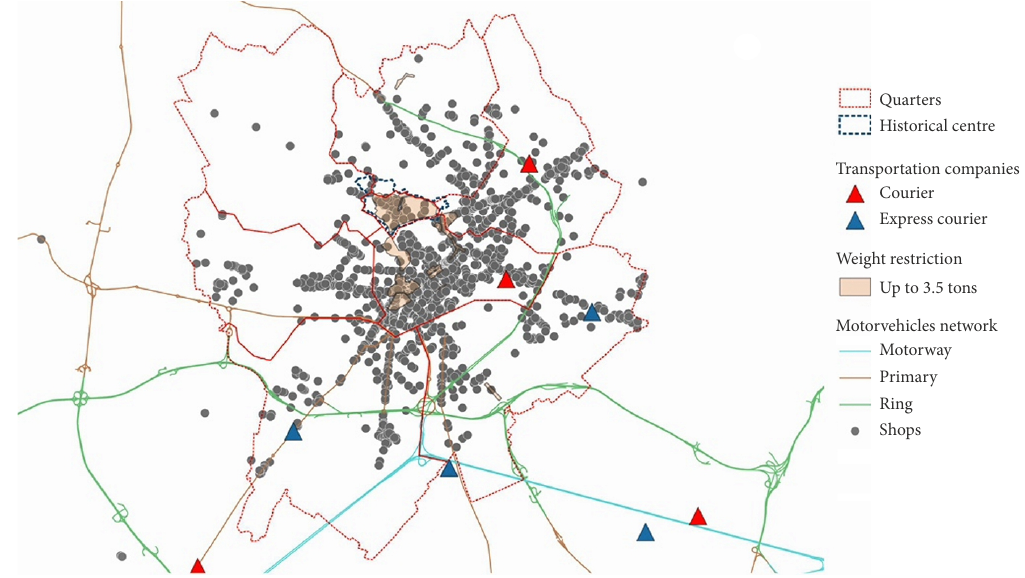
Figure 2. A selection of layers used to evaluate potential locations for a UDC